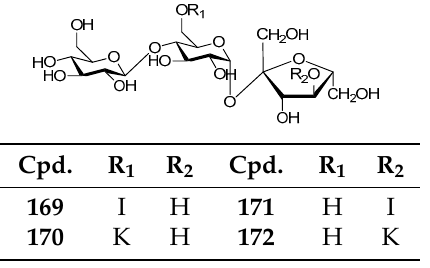
Figure 20. Structures of compounds 173 – 174 .